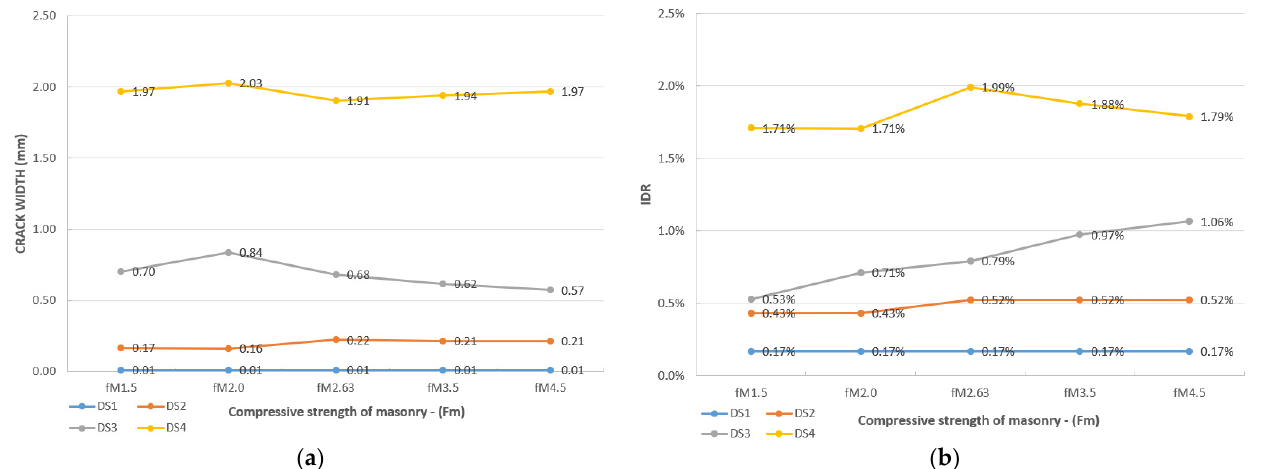
Figure 14. Correlation of damage states (DS) and yield strength of reinforcement (f y ) associated with: ( a ) crack width (mm); ( b ) IDR (%).